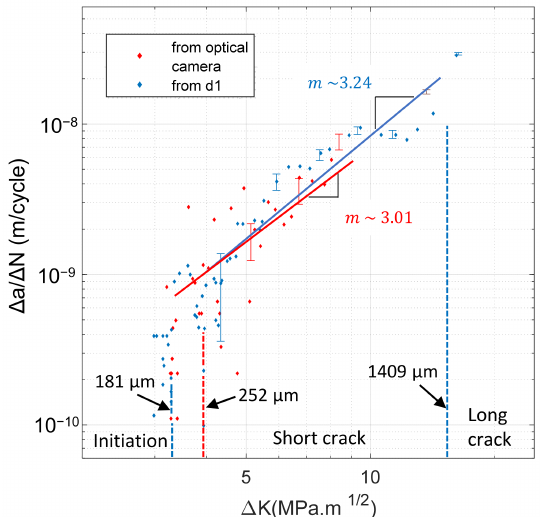
Figure 11. The evolution of the fatigue crack growth rate (m/cycle) in terms of the stress intensity factor ranges from the optical results (red dots) to d 1 (blue